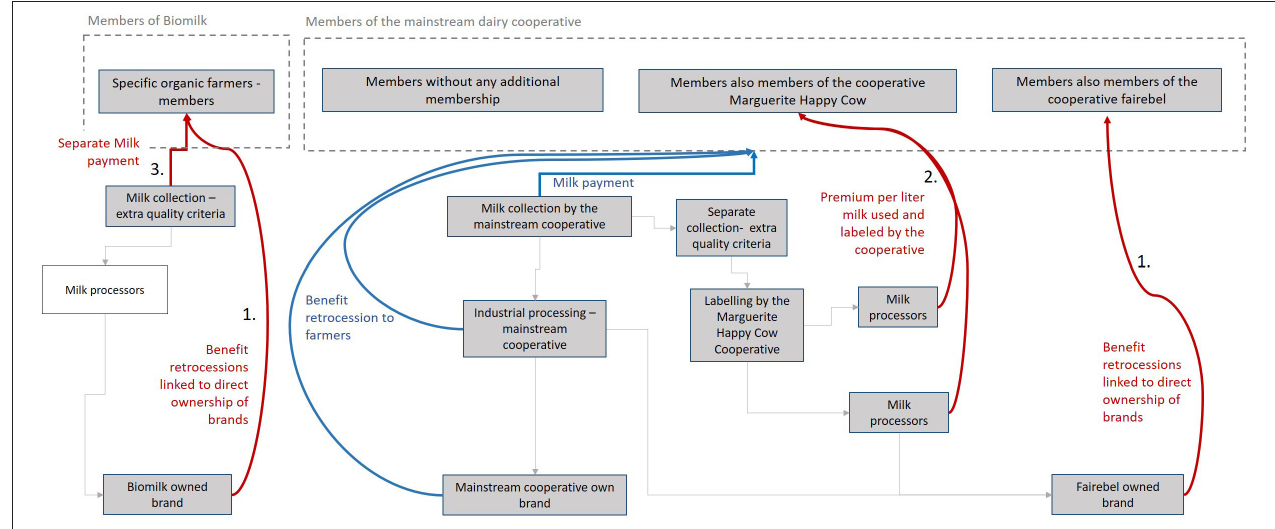
FIGURE 2 | Graphical representation of the enlargement of the fluxes of redistribution of the added value to farmers through the new cooperative